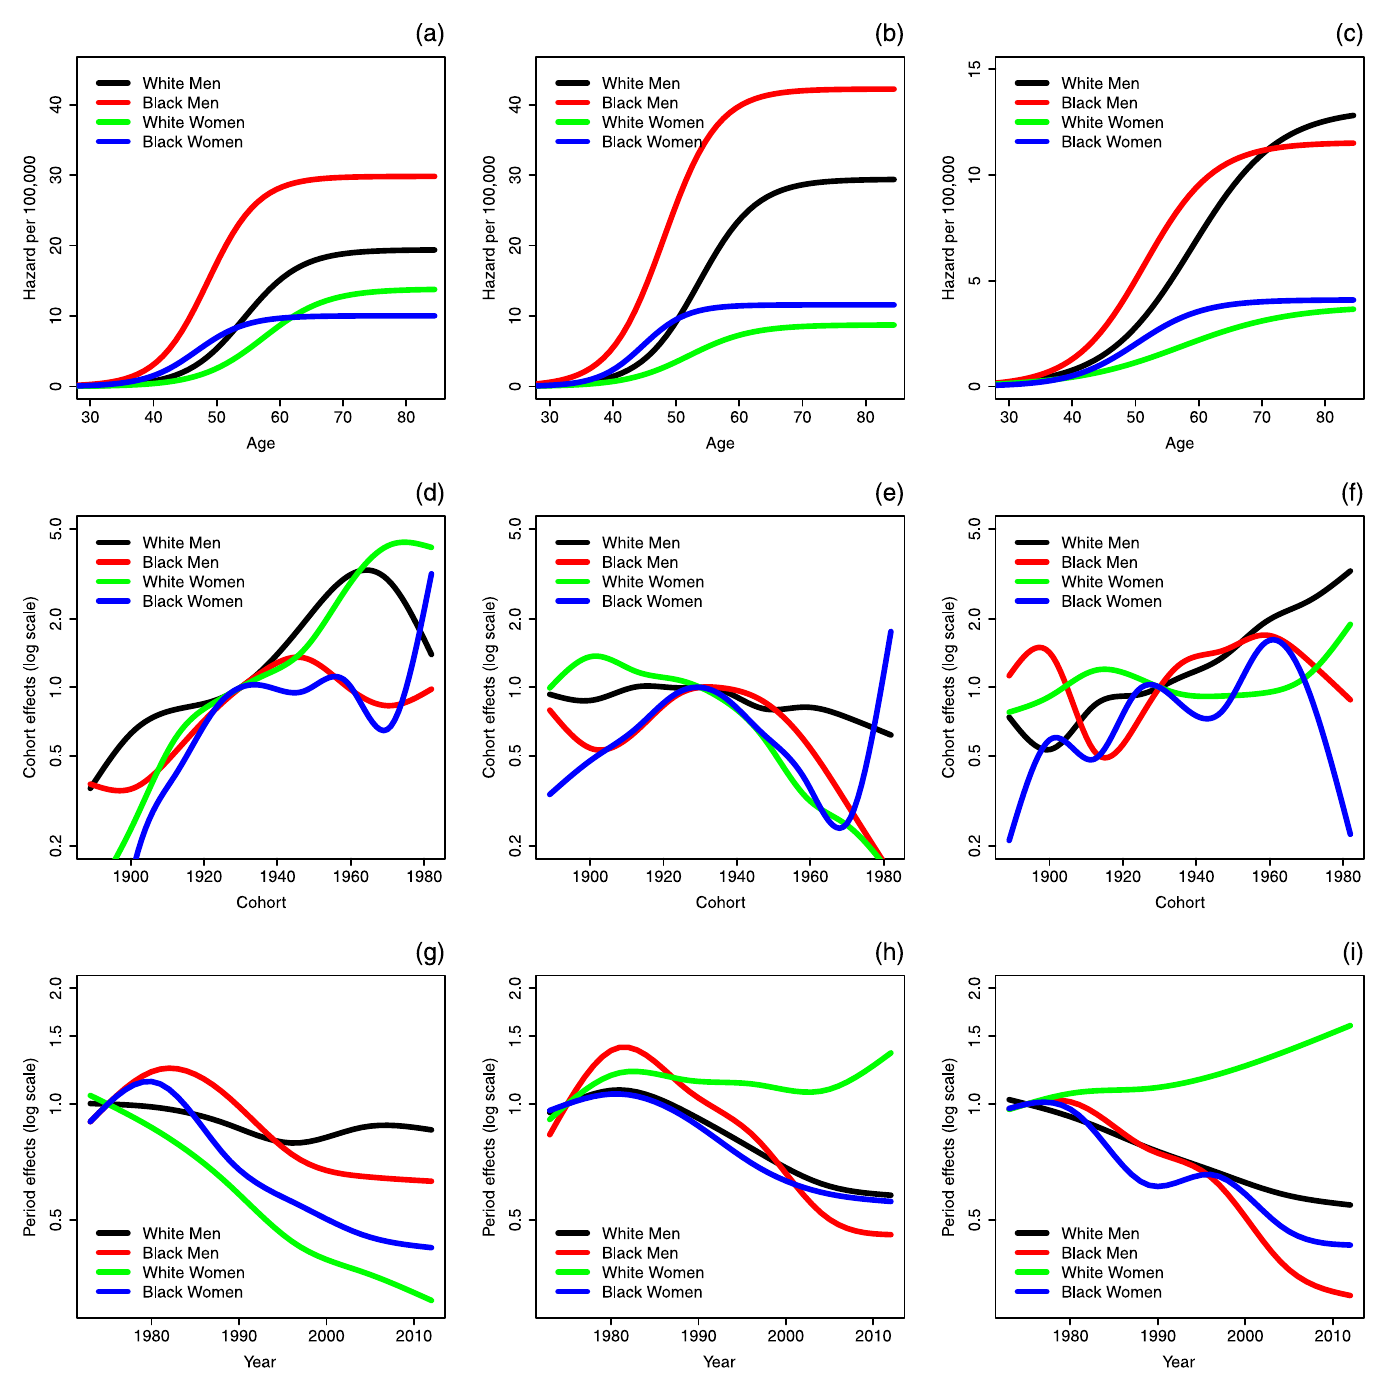
Fig 5. Hazard, cohort effects, and period effects for the cohort-and-period-effects-on- r APC — TSCE models of oral squamous cell carcinoma by race and cancer subsite group. (a) HPV-related hazards. (b) HPV-unrelated hazards. (c) Oral tongue hazards. (d) HPV-related cohort effects. (e) HPV- unrelated cohort effects. (f) Oral tongue cohort effects. (g) HPV-related period effects. (h) HPV-unrelated period effects. (i) Oral tongue period effects.